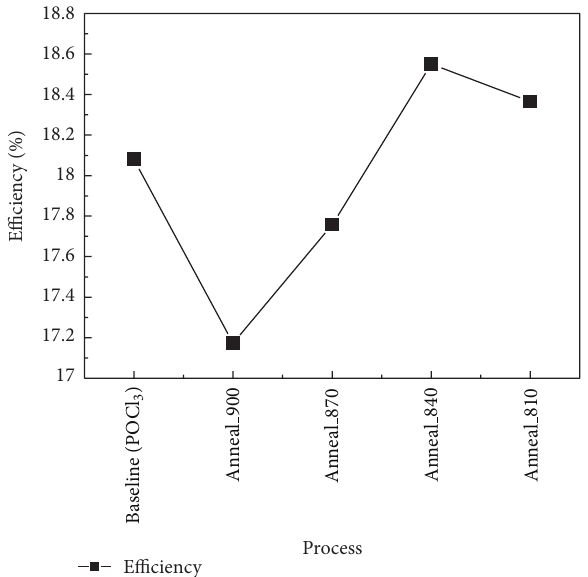
Figure 10: Efficiency for the POCl 3 diffusion and implantation processes.